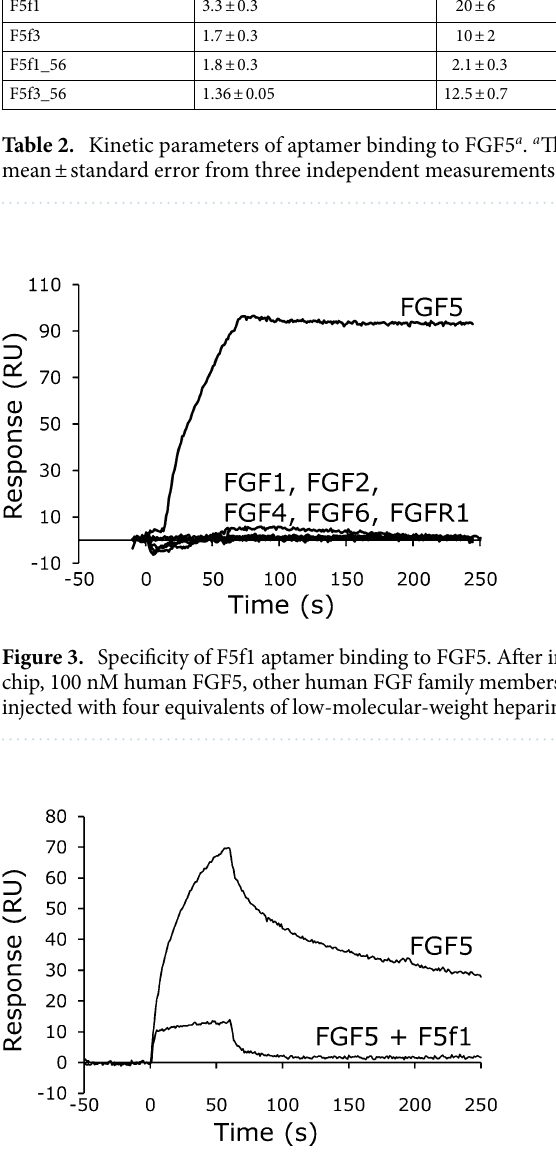
Figure 4. Competitive inhibition of the binding of FGF5 to FGFR1 by the F5f1 aptamer. After immobilization of the extracellular domain of human FGFR1 on the sensor chip, a mixture of 100 nM human FGF5 and 100 nM low-molecular-weight heparin was injected with or without 200 nM F5f1